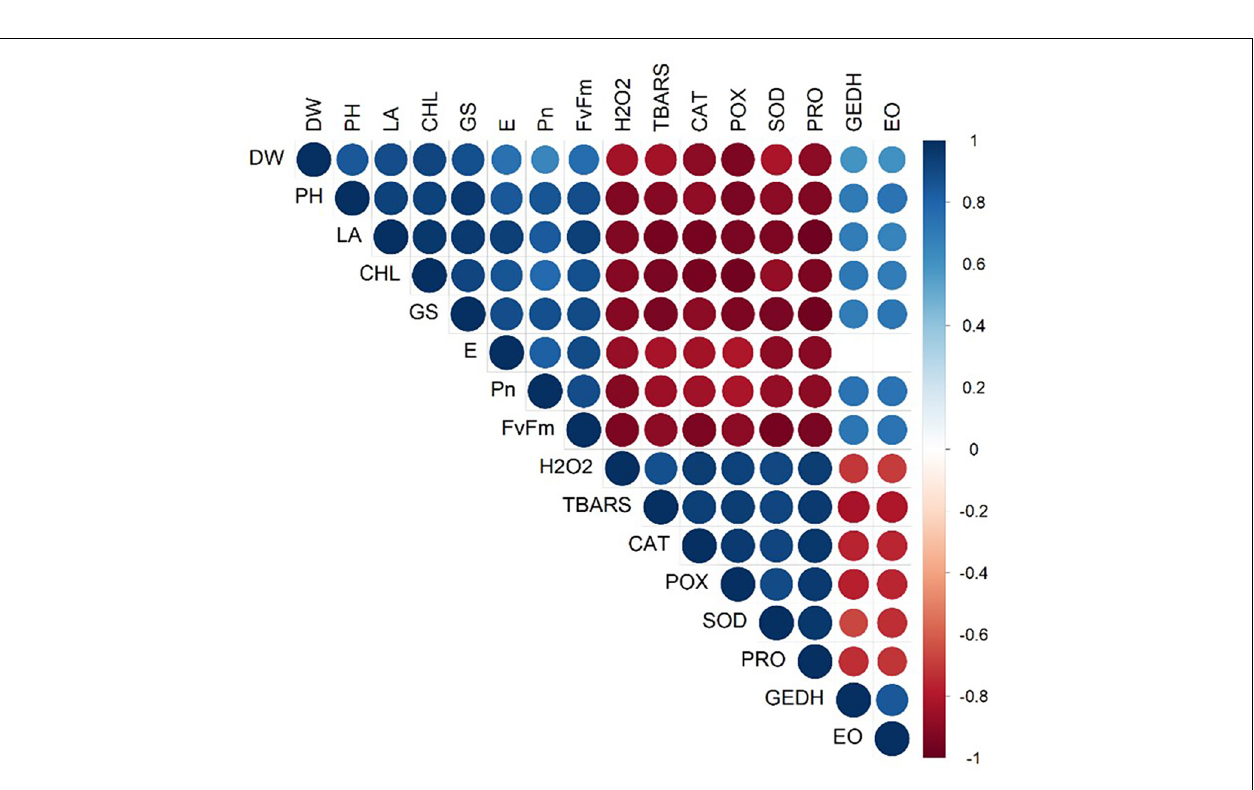
Frontiers in Plant Science |